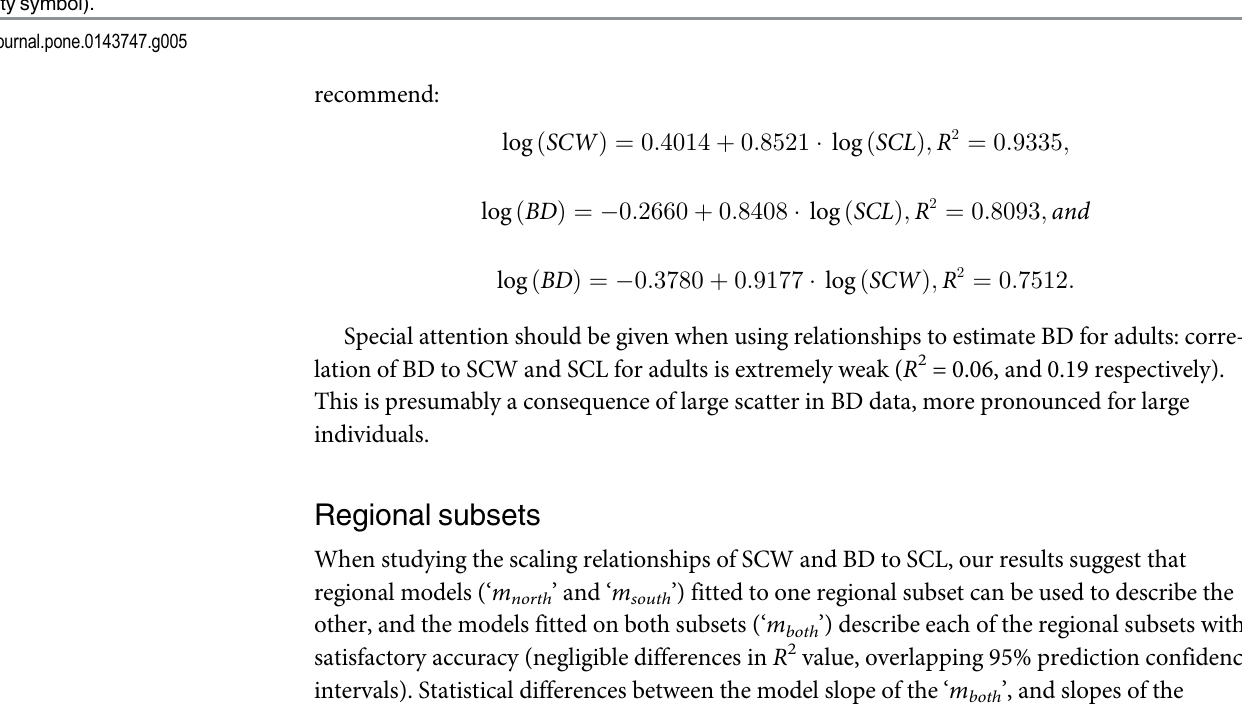
Fig 5. Predictions of SCW and BD by two types (M1 — linear, and M2 — saturating) of models ‘ m I ’ , ‘ m II + III ’ , and ‘ m I + II + III ’ . Predictions are given for average sizes at specific events (hatching, recruitment, nesting). Symbols are coded based on the model (each symbol corresponds to one model), and type (full or empty